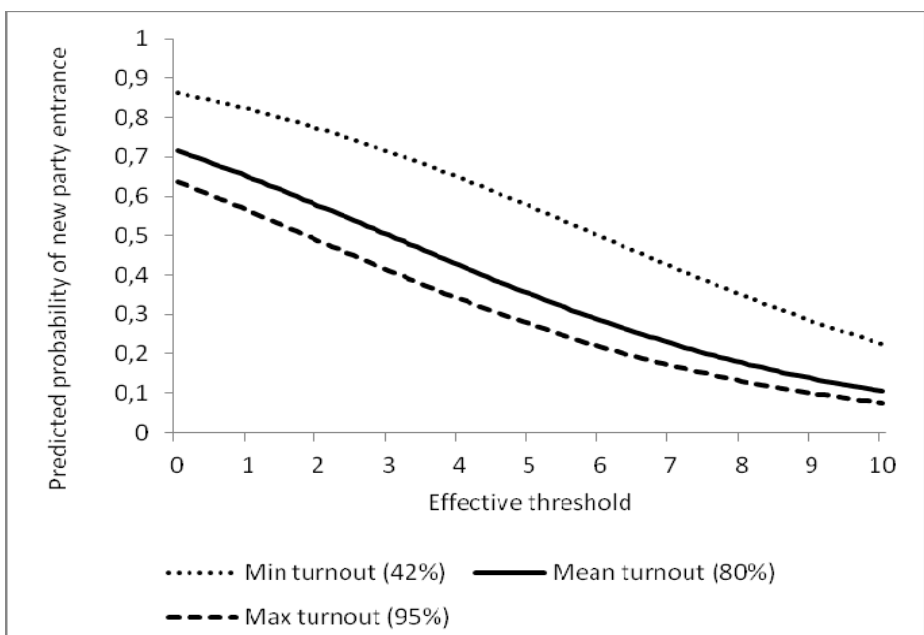
Figure 2. Predicted probabilities of new party parliamentary entry; effective threshold and